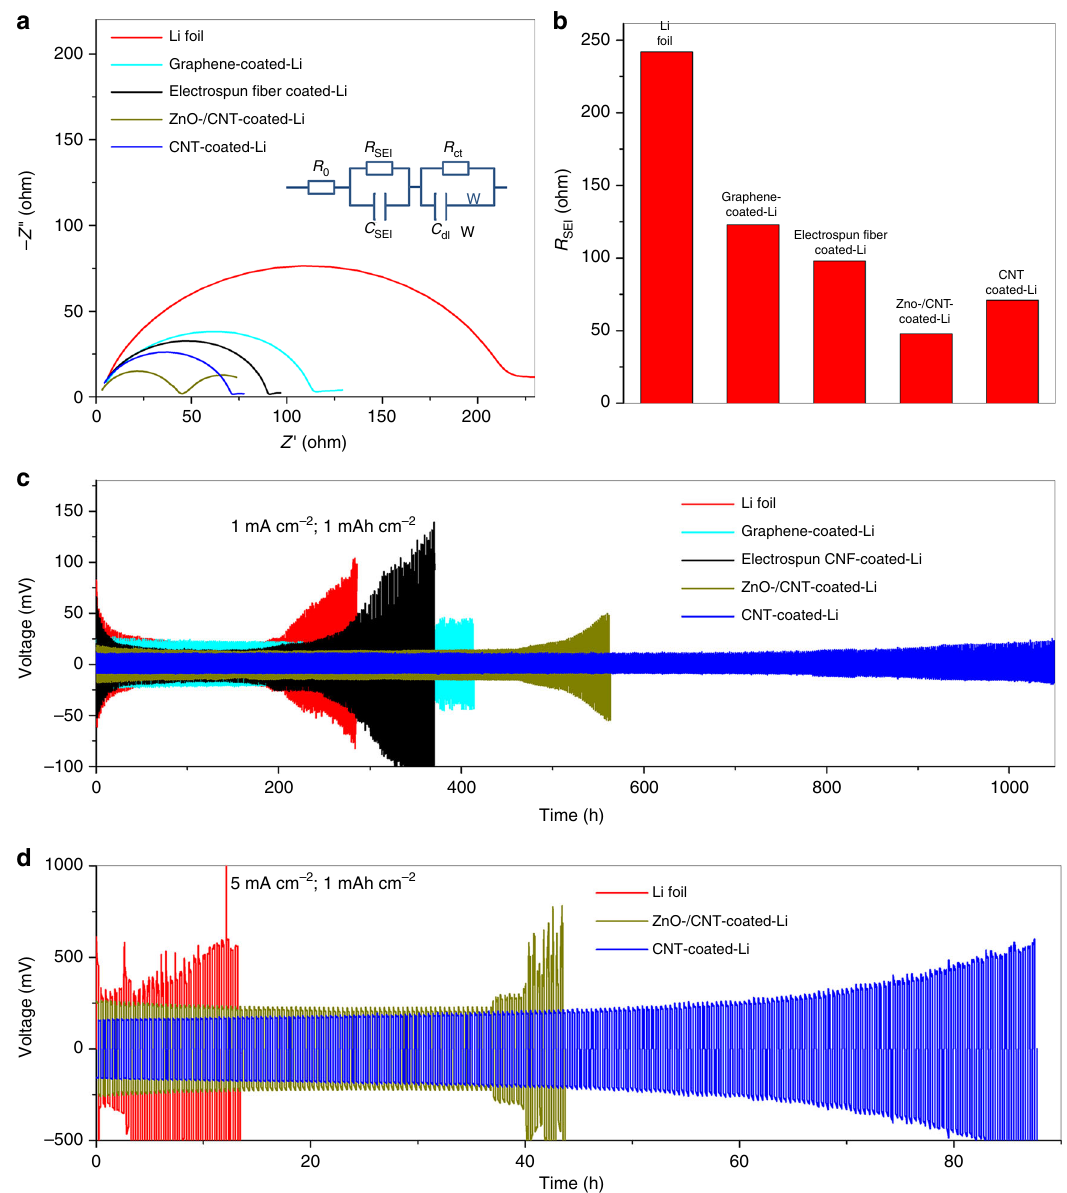
Fig. 3 Electrochemical performance of a blank cell and the cells assembled by Li foils with various interfacial layers. a Electrochemical impedance spectra of various cells (inset in Fig. 2a: equivalent circuit for fi tting the impedance results). Frequency: 0.1 Hz – 1 MHz, perturbation amplitude 5 mV, measured at 0% state of charge (SOC). b Comparison of R SEI fi tting results of all cells. c , d Comparison of the cyclability of a symmetric cell assembled by blank Li foils (red) and Li foils with interfacial layers of graphene (light blue), electrospun fi ber (black), ZnO/CNT (dark yellow), and CNT (blue), respectively, at current densities of c 1 and d 5 mA cm − 2 with a deposition/dissolution capacity of both 1 mAh cm − 2 for c 520 and d 220